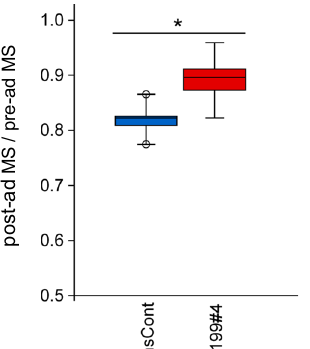
Fig. 7 Grip strength test of aged mice. Eighty-week-old (20-month-old) C57BL/6J mice were subjected to the grip strength test, and 1 week later, miR199#4 (199#4) and nsCont were intravenously administered. The grip strength test was carried out again 9 weeks later. The data were normalized by body weight, and the ratio of post-administered muscle strength (post- ad MS) to pre-administered muscle strength (pre-ad MS) was calculated. Data are shown as mean ± SEM [ n = 5 mice; * p < 0.05 by Student ’ s t test (two-tailed)].